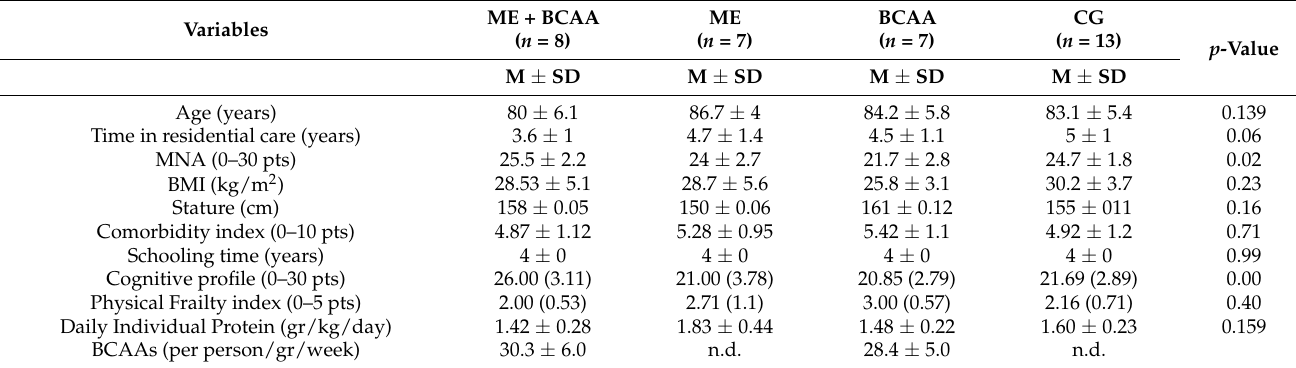
Table 3. Characterization of participants by intervention groups at